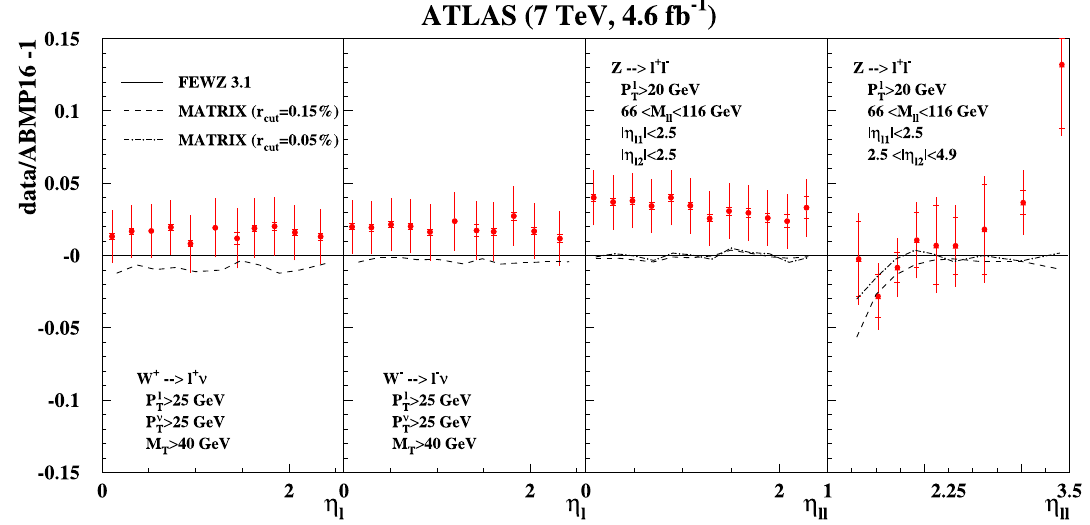
= 0 . 15% (dashed) and r min